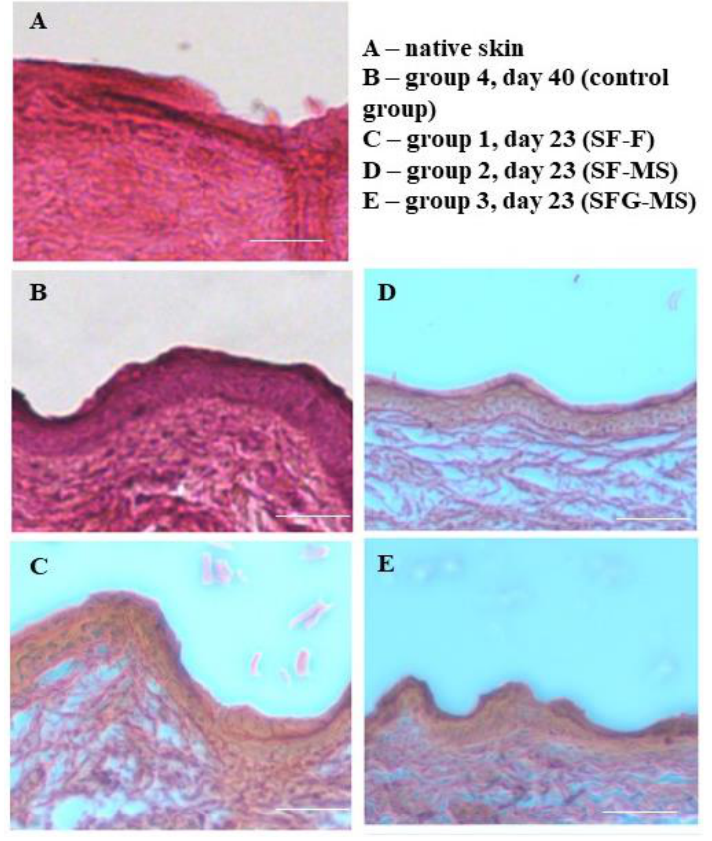
Figure 8. Histological evaluation in the area of complete wound healing (A = 100%), magnification ×100, and scale bar: 100 μ m. ( A ) native skin; ( B ) group 4, day 40 (control group); ( C ) group 1, day 23 (SF-F); ( D ) group 2, day 23 (SF-MS); ( E ) group 3, day 23